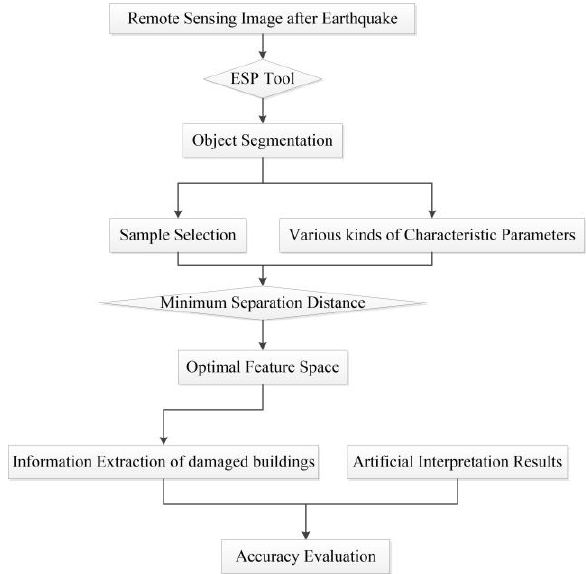
Figure 2 The extraction technical process of damaged